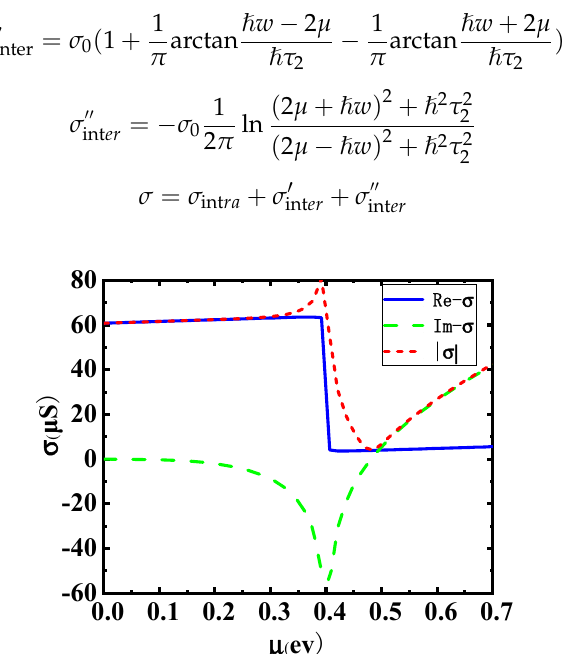
Figure 3. The image of conductivity as a function of chemical potential.